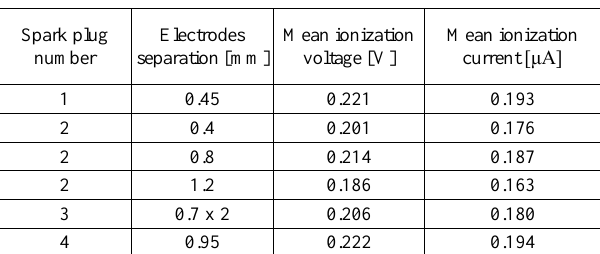
Table 3. Ionization signal measurement results for selected spark plugs Spark plug